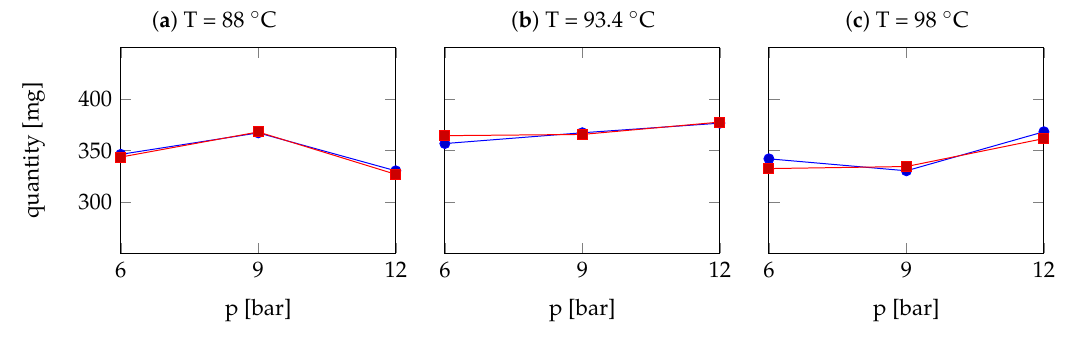
Figure 3. Comparison between the caffeine extracted through numerical simulations (blue profile with circles) and laboratory measurements (red profile with squares), with different inlet water temperatures and pressures and different grain size of Arabica coffee powder. Figures ( a – c ) show the results of optimal granulometry, Figures ( d – f ) of coarse granulometry and Figures ( g – i ) of fine granulometry.